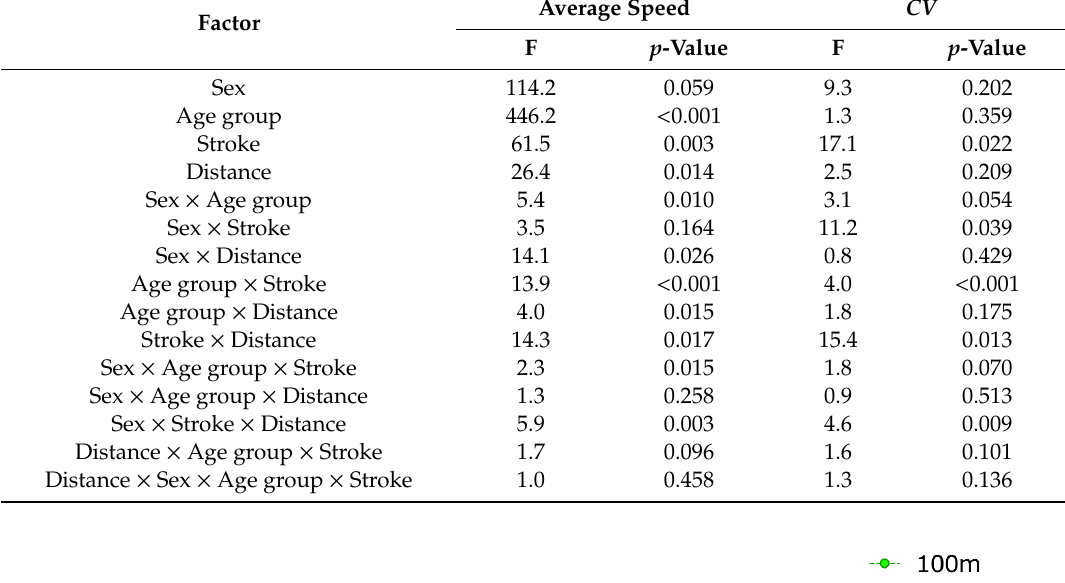
Table 2. Multifactorial model with dependent variables being average swimming speed and coefficient of variance (CV).